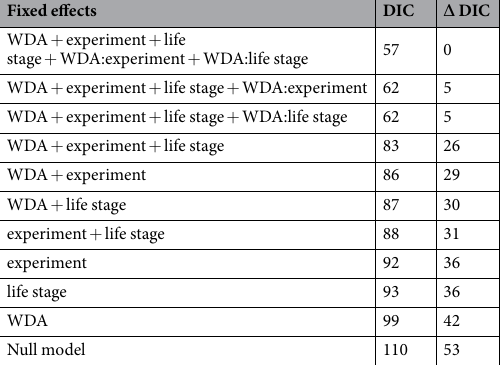
Table 4. Comparison of Bayesian phylogenetic mixed models describing the relationship between drought- induced mortality ( ∆ m) and water deficit affiliation (WDA) for Neotropical tree genera. Models vary in how they account for the influence of experiment (Tapajós or Barro Colorado Island) and life-history stage (saplings or trees) and are compared based on deviance information criteria (DIC). Data on ∆ m were obtained from the Tapajós through-fall exclusion experiment 40 and from the 1982 El Niño drought in BCI 17 . WDA values were taken from ref. 39. Models based on an uninformative prior inverted gamma distribution, following ref. 75. Posterior was obtained after 130 000 iterations, burn-in = 30 000 and thinning interval = 100 ref. 75. Note that the best models are the ones including WDA, experiment and life history stage, and the interactions of WDA with experiment and life